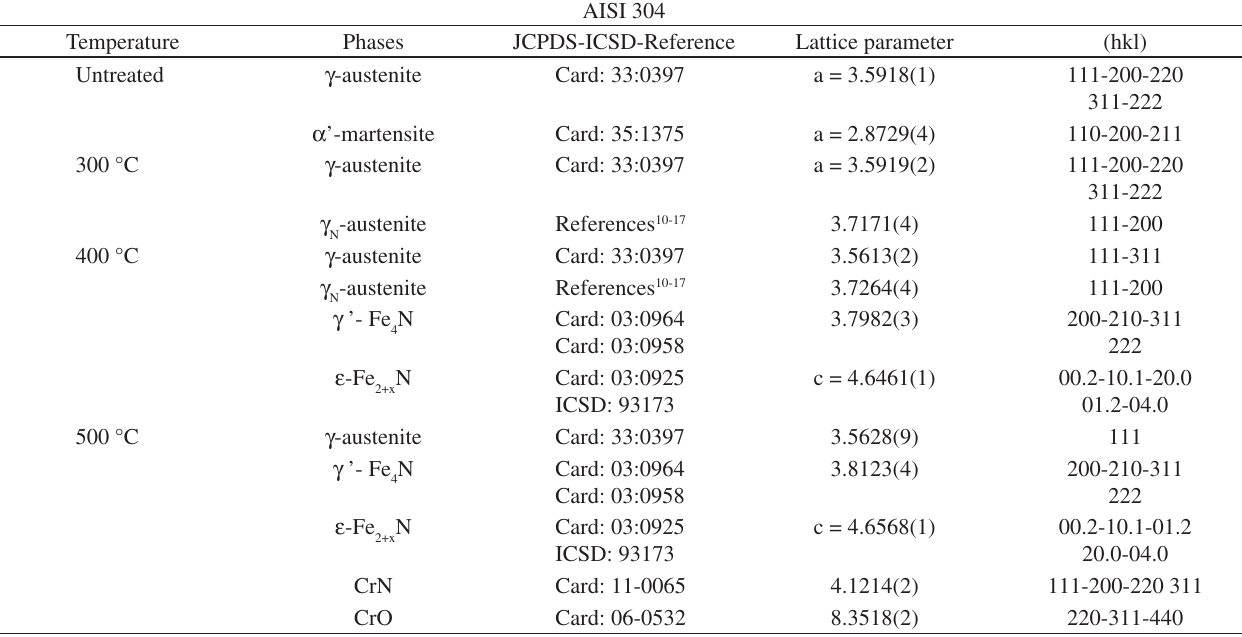
Table 1. Phases, lattice parameters, space group and symmetry for untreated and nitrided AISI 304.